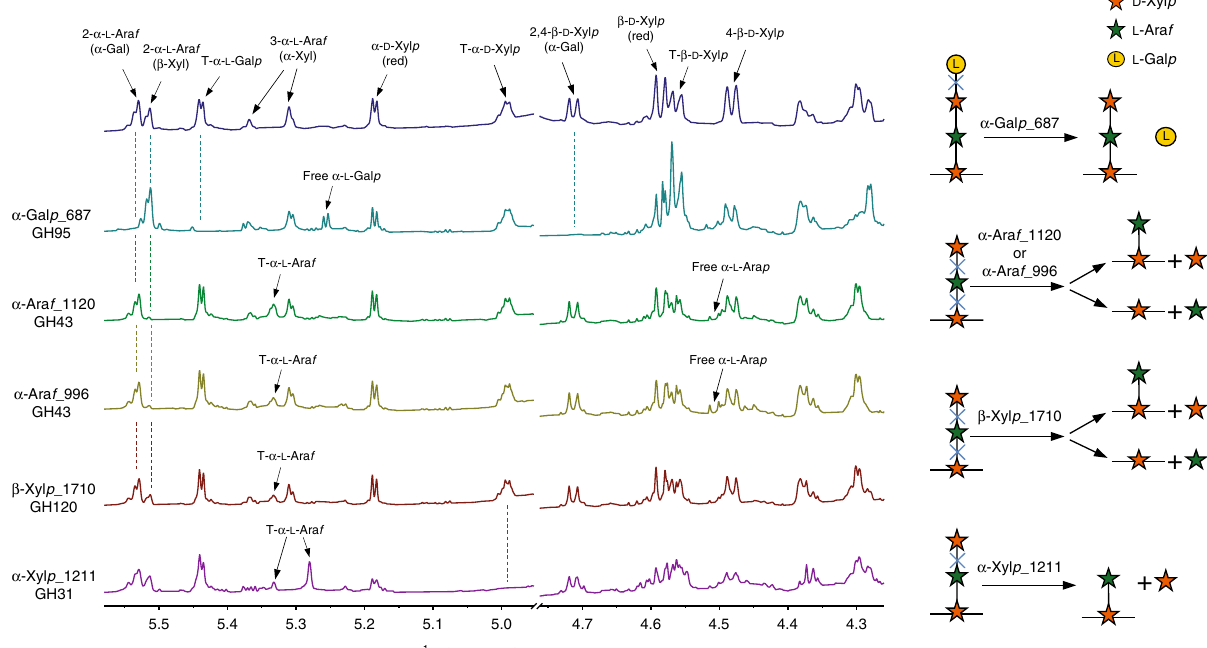
Fig. 2 Activity of the puri fi ed enzymes against the Coculture Broth neutral oligosaccharides. 1D 1 H NMR analysis of products generated by individually incubating the puri fi ed enzymes with a mixture of neutral oligosaccharides (DP 4-9) isolated from TS -Coculture Broth. Data correspond to 2 h incubation beyond which no further activity was detected. The signals labeled terminal (T) α - L -Ara f in the α -Ara f _1120, α -Ara f _996, and β -Xyl p _1710 spectra correspond to T- α - L -Ara f attached to O -3 to the backbone xylose. The T- α - L -Ara f -label in the α -Xyl p _1211 spectrum indicated the signal for T- α - L -Ara f attached to O -2. The xylose at the reducing end of the oligosaccharide are labeled red. A scheme of the enzymatic reaction for each enzyme is included on the right side of the fi